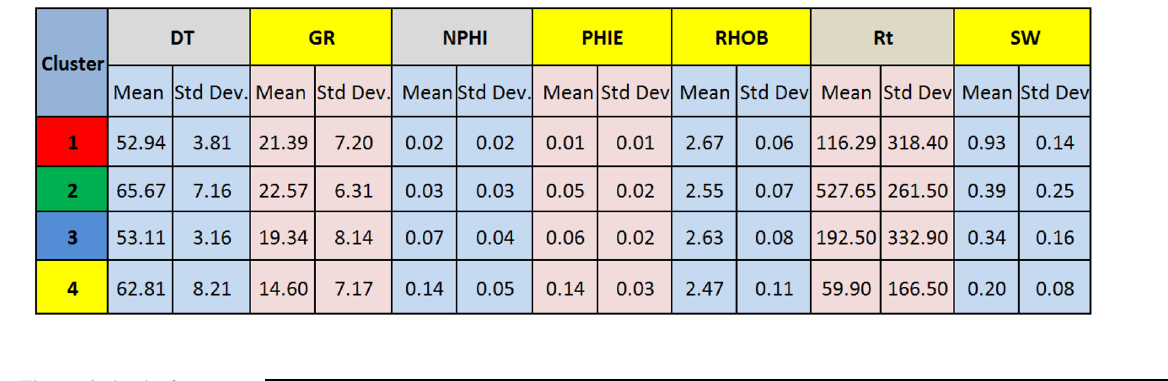
Table 5 Flow unit depths for Yamama formation in Ratawi